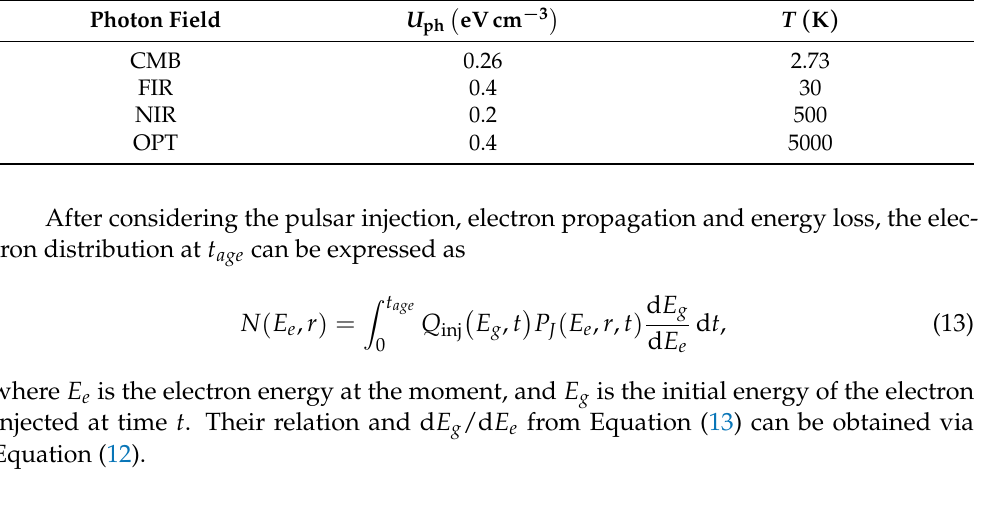
Table 1. Parameters of photon